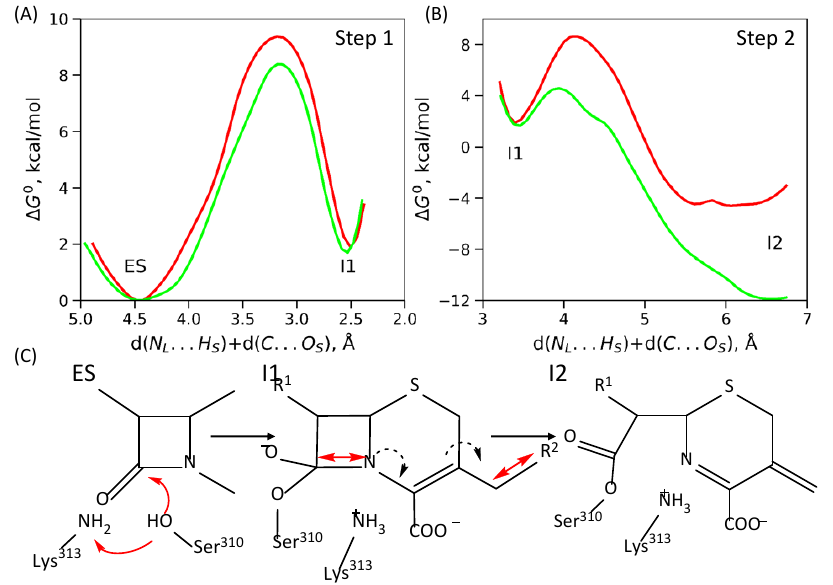
Figure 4. ( A , B ) Gibbs energy profiles of the elementary steps of ceftriaxone acylation in the active site of PBP2 35/02 (green) and PBP2 H041 (red); all energy values are relative to the ES. ( C ) Molecular mechanism of this reaction; plain red arrows are reaction coordinates; dashed black arrows depict redistribution of electron pairs.